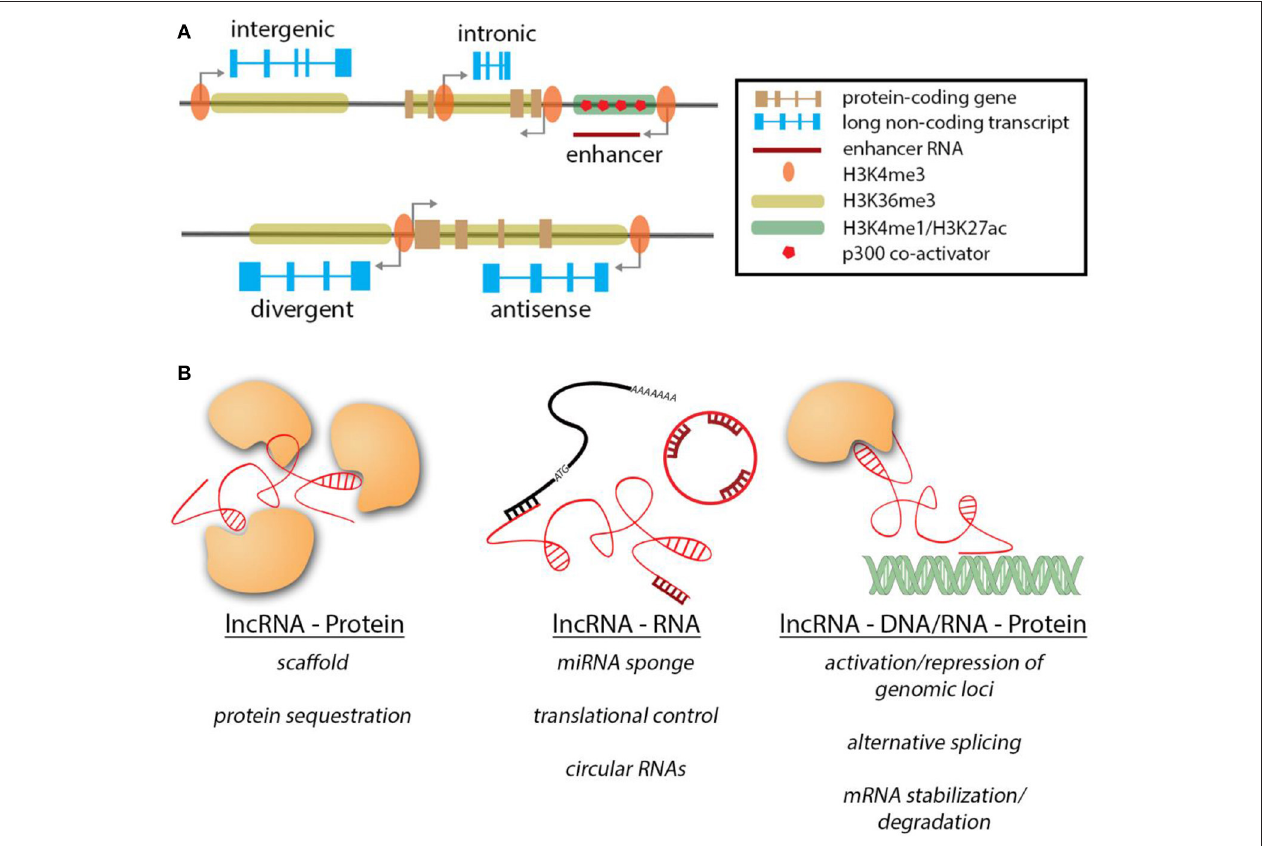
FIGURE 1 | Genomic contexts of lncRNAs & modes of action. (A) LncRNA genes (blue) can exist in various genomic contexts. The histone marks are similar to protein-coding genes. NcRNAs transcribed from enhancer regions are unique in their features. (B) Overview of the different interactions of lncRNAs and their target